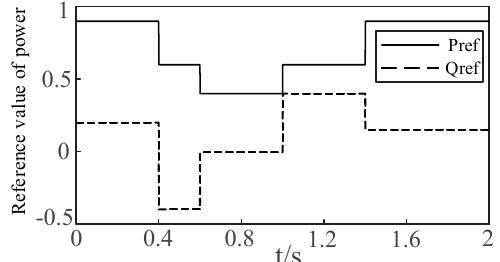
Figure 4. Reference value of power of the converter.